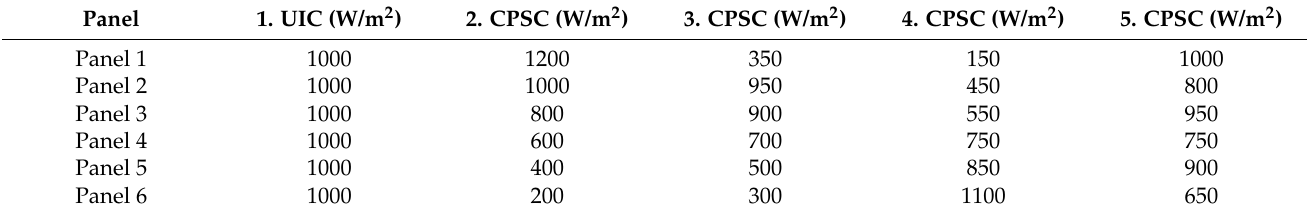
Table 2. Uniform and complex partial shading conditions.